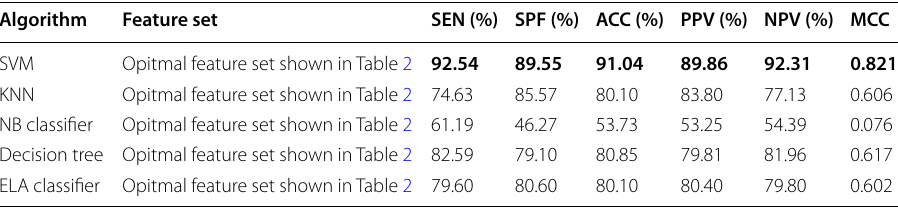
Bold values to highlight the relevant numbers